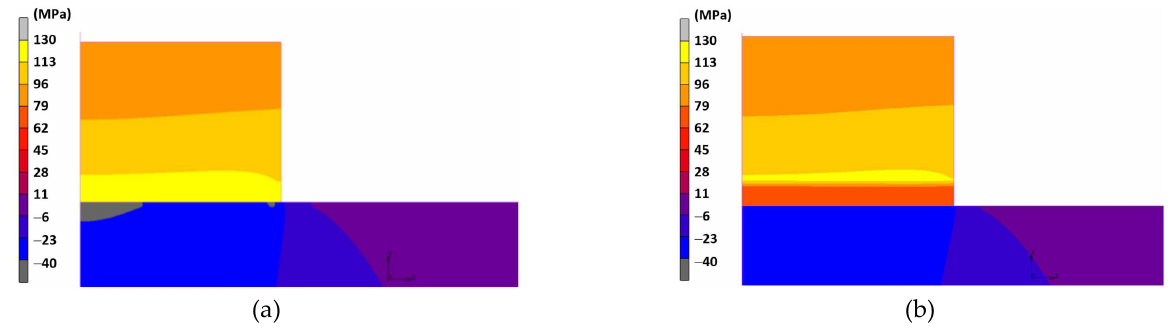
Figure 6. Distributions of the tangential stress in: ( a ) a conventional shrink fit (without a contact ring), and ( b ) a modified shrink fit with a contact ring ( γ = 0.050).